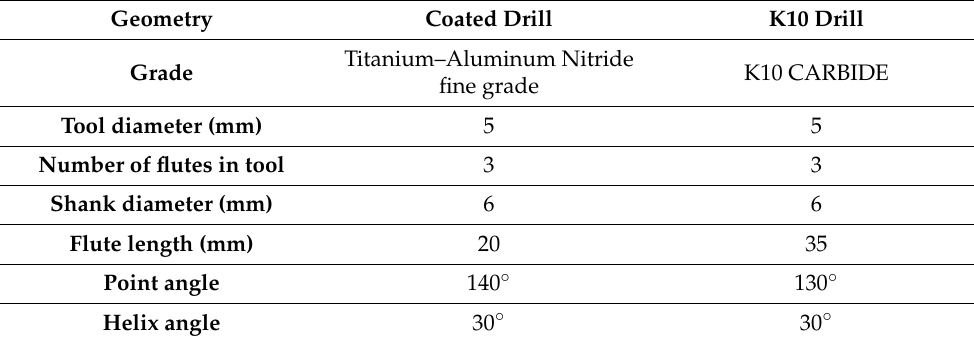
Figure 1. Kennametal™ twist drills: ( a ) TiAlN PVD coated. ( b ) Uncoated carbide. ( c ) Representative microstructure of Mg-9Al-1.4Zn -15% hollow alumina syntactic foam. ( d ) Compression stress–strain curve for Mg-9Al-1.4Zn -15% hollow alumina syntactic foam @ strain rate: 1 s − 1 . Table 2. Properties of Kennametal™ drill tools.